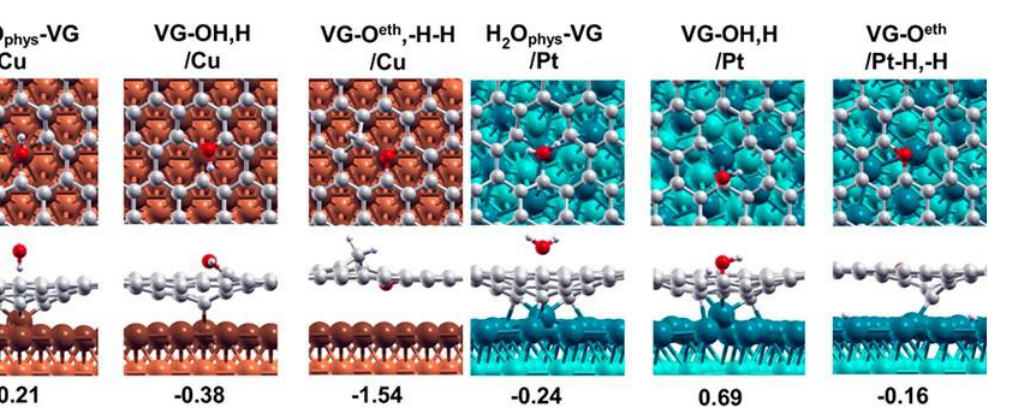
Figure 3. Most stable products along the dissociation path of H 2 O for (orange, left) VG/Cu and (light blue, right) VG/Pt interfaces. From left to right: physisorbed state, first dissociation (−OH/−H), and complete dissociation (−O/−H/−H). Taken with permission and adapted from Ref. [13]. Copyright by ACS.